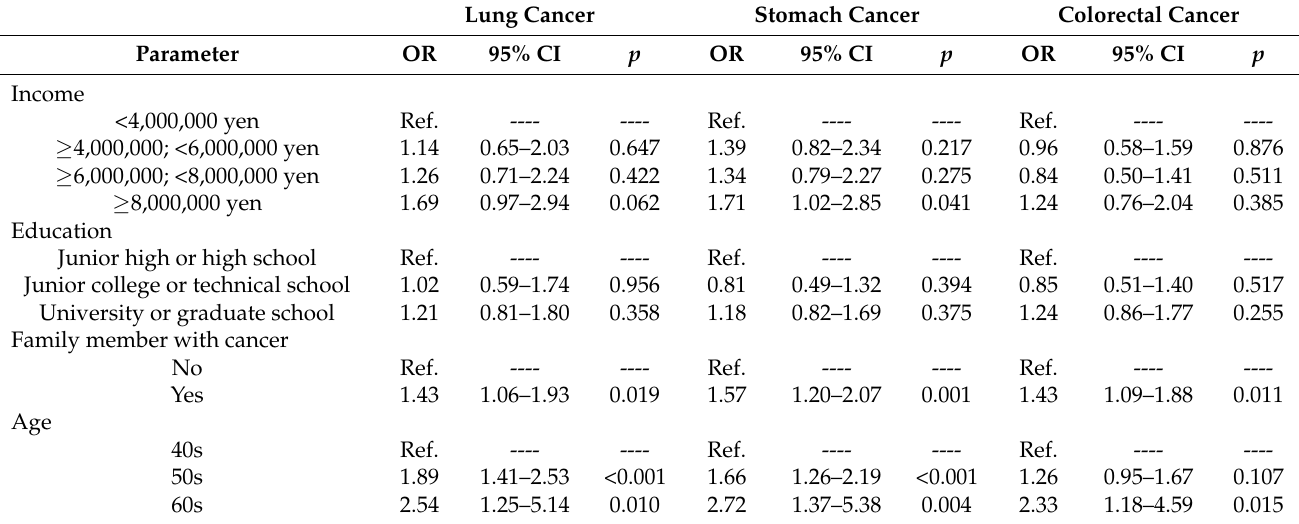
Table 4. Factors associated with site-specific cancer screening experience in